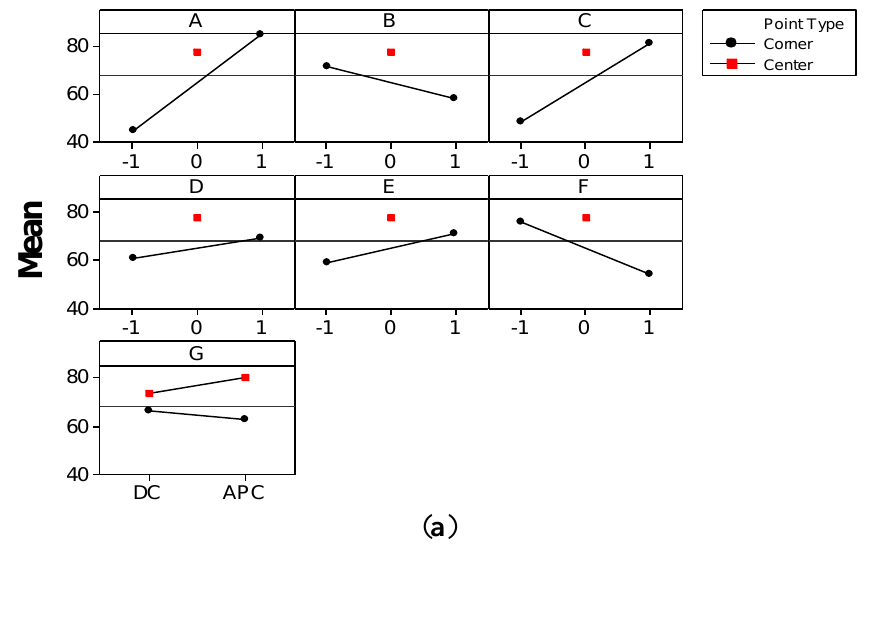
Figure 8. ( a ) Main effects; and ( b ) interactions plots pointing out the effects on color removal efficiency. Solid lines represent low black levels (−1 and DC ) of the factors; dashed green lines represent high levels (1 and APC ); dashed red lines represent the center levels (0); left ends of the lines in each plot means low level of underlying factors, and the right ends depicts higher